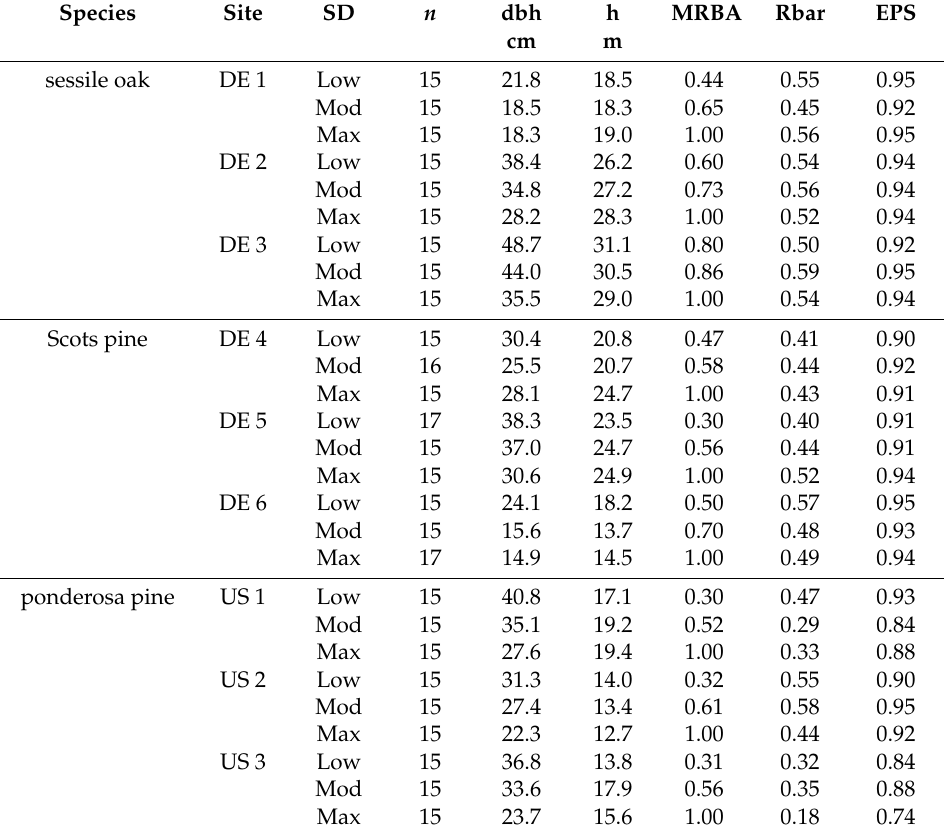
Table A2. Mean tree and chronology characteristics by species, site and stand density level ( SD ). n : number of trees sampled. dbh : diameter at breast height. h : tree height. MRBA : weighted mean relative stand basal area. Rbar : inter-series correlation. EPS : expected population signal.